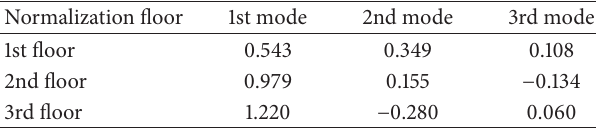
Table 2: Modal participation factors of example structure.